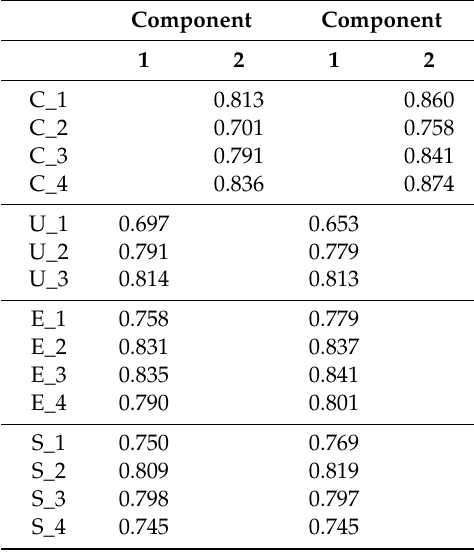
Table 5. Component matrix and rotated component